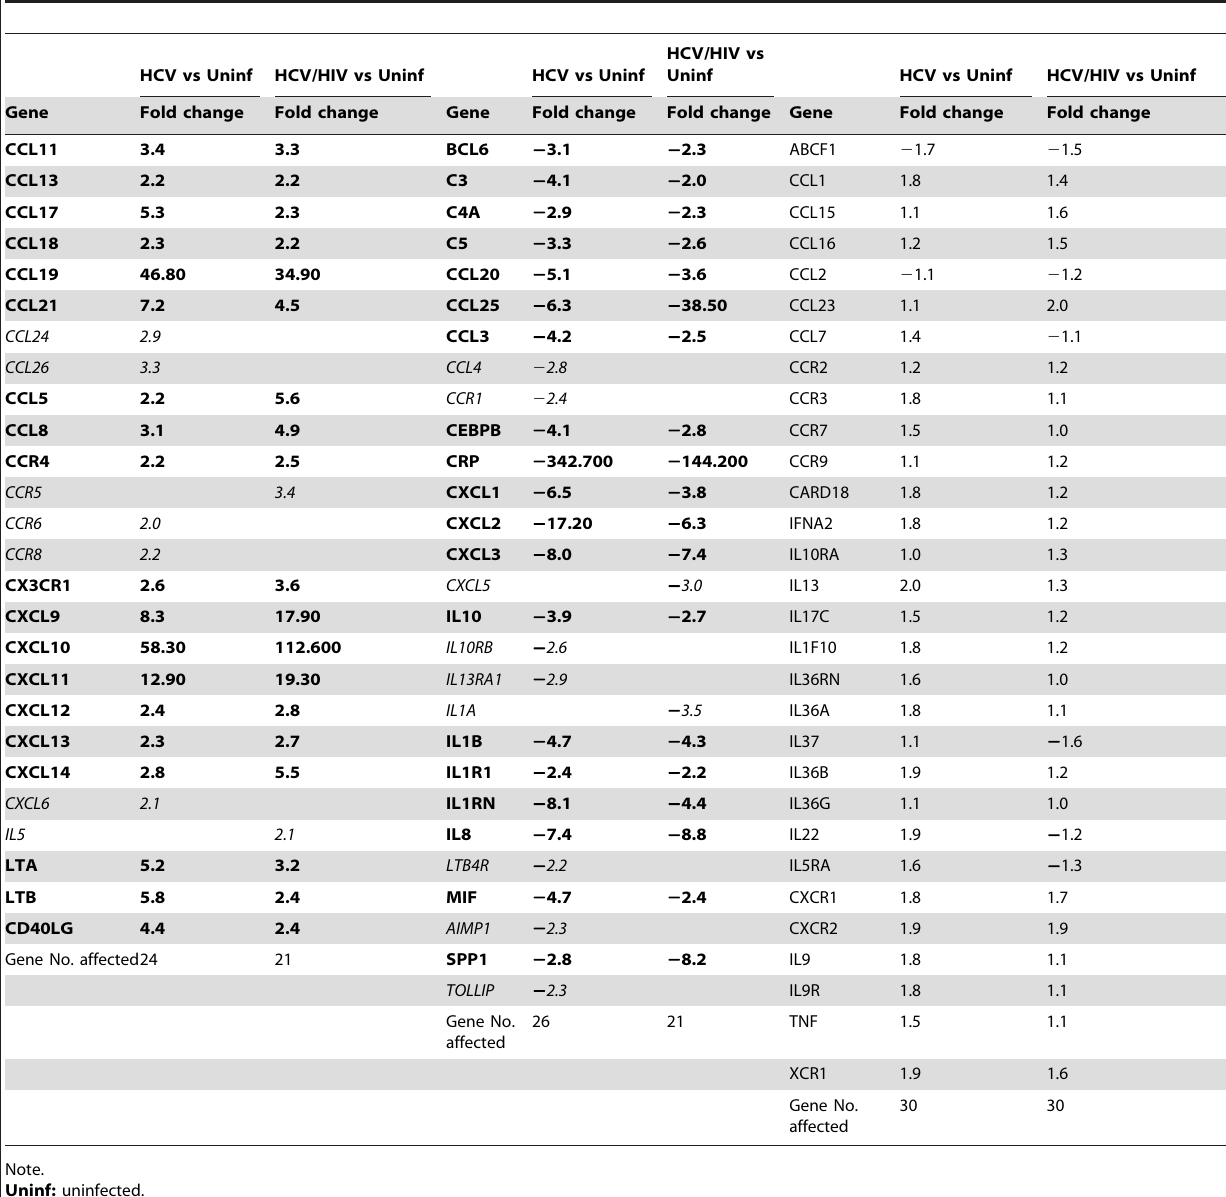
Table 3. Regulation of intrahepatic inflammatory gene expression by HCV infection or HCV/HIV-1